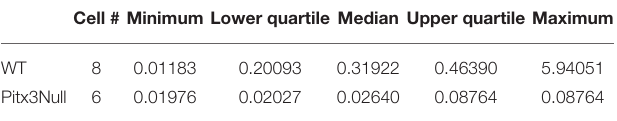
TABLE 2 | Baseline firing rates in antidromically identified striatonigral neurons. Cell # Minimum Lower quartile Median Upper quartile